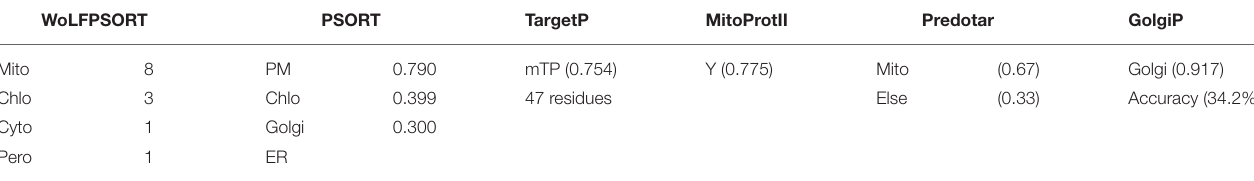
TABLE 1 | Prediction of OsCYP21-4 subcellular localization by website